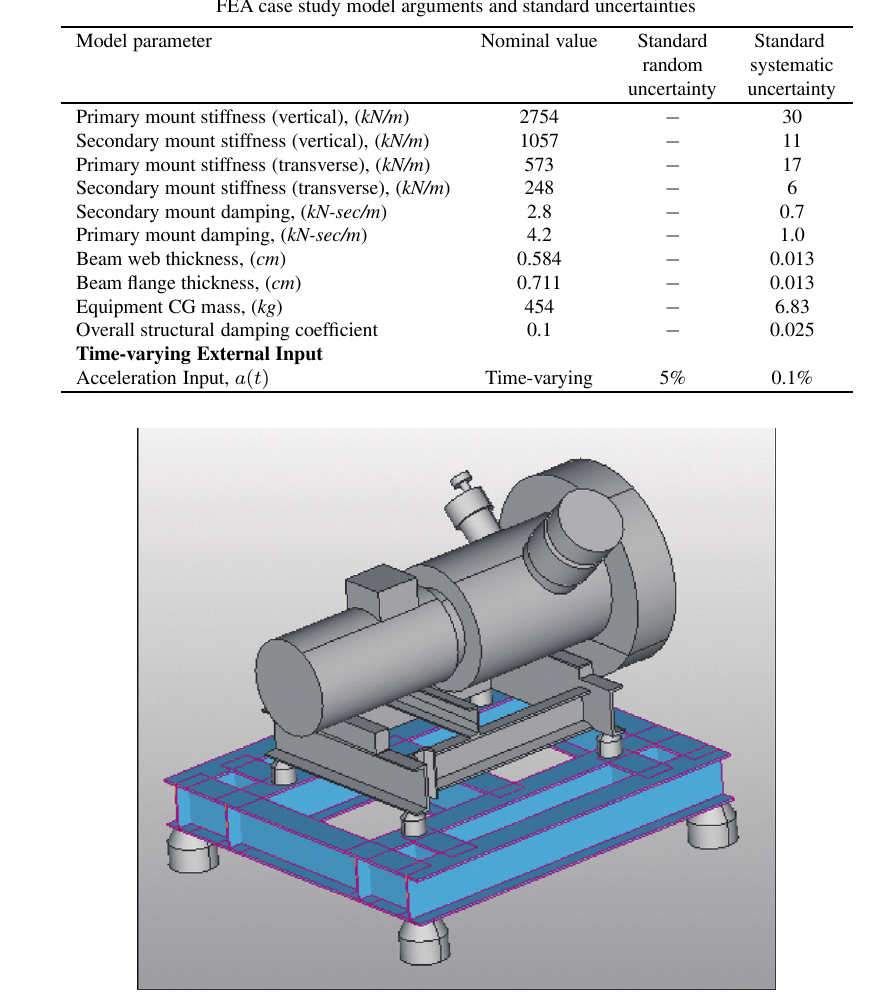
Fig. 10. Double-isolated equipment (air